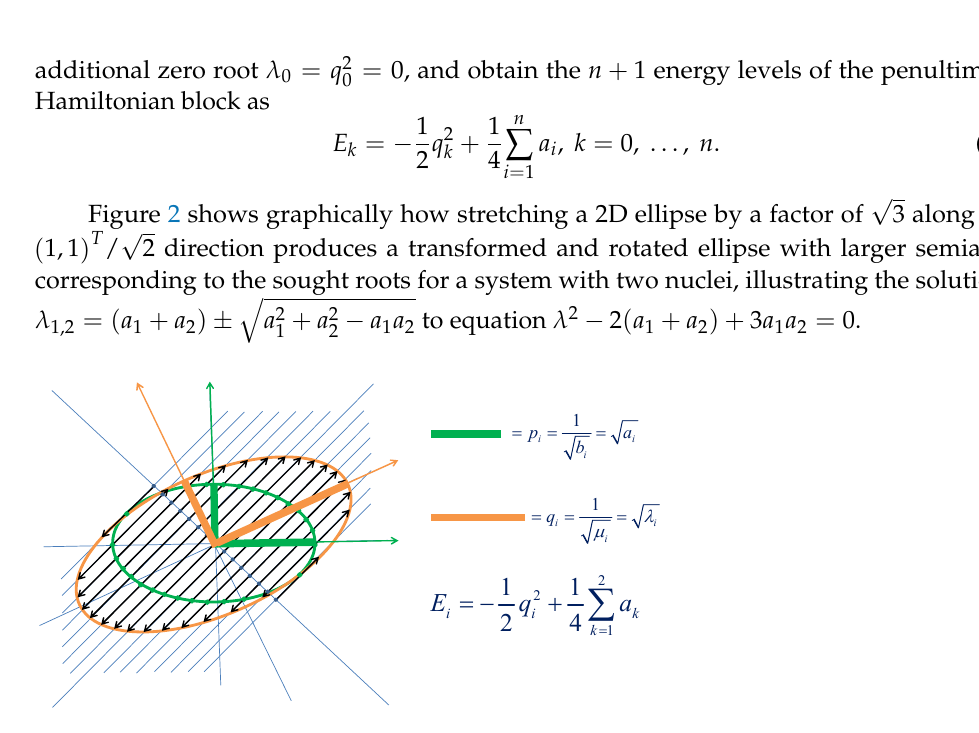
Figure 2. Stretching the representing ellipse for a two-nuclei system with a 1 = 25 and a 2 = 9 relative √ √ units, corresponding to semiaxes of 5 and 3 r.u., along the direction ( 1,1 ) T / 2 by a factor of 3 to obtain the roots as the squared semiaxes of the transformed ellipse. The figure shows the initial and √ resulting ellipses with their semiaxes as bold sticks, the stretch lines along the ( 1,1 ) T / 2 direction and the reference line normal to them, the old and new Cartesian axes for the ellipses, and the correspondence of the points at the cross-section of the initial ellipse with the stretch lines and their √ images at the final ellipse that are a factor of 3 farther away from the reference line along the stretch lines.